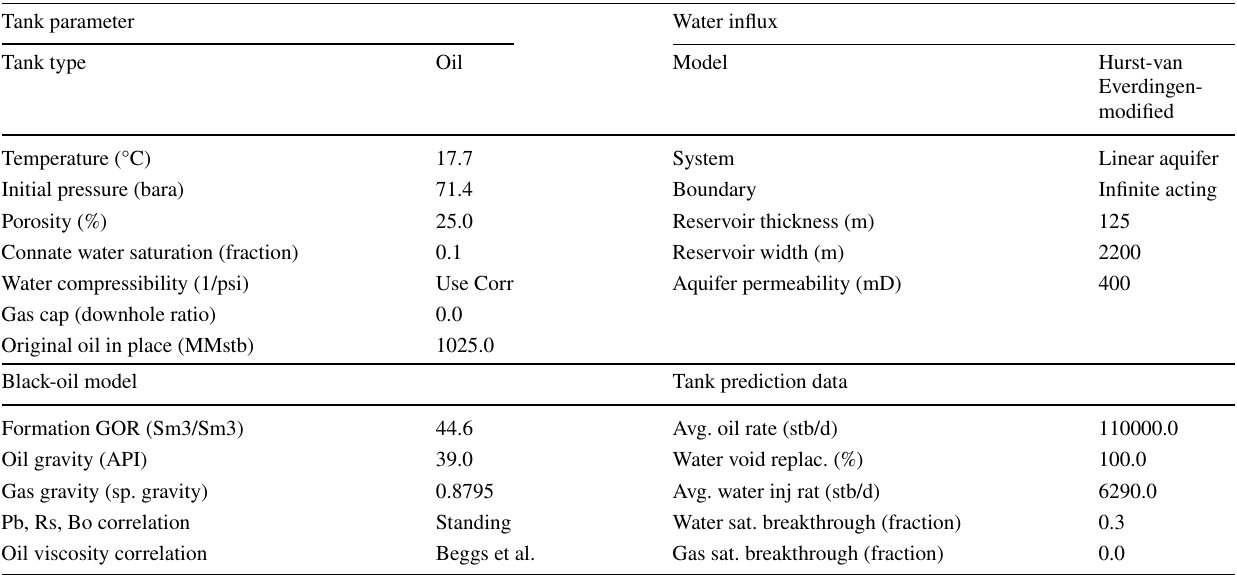
Table 14 Reservoir model